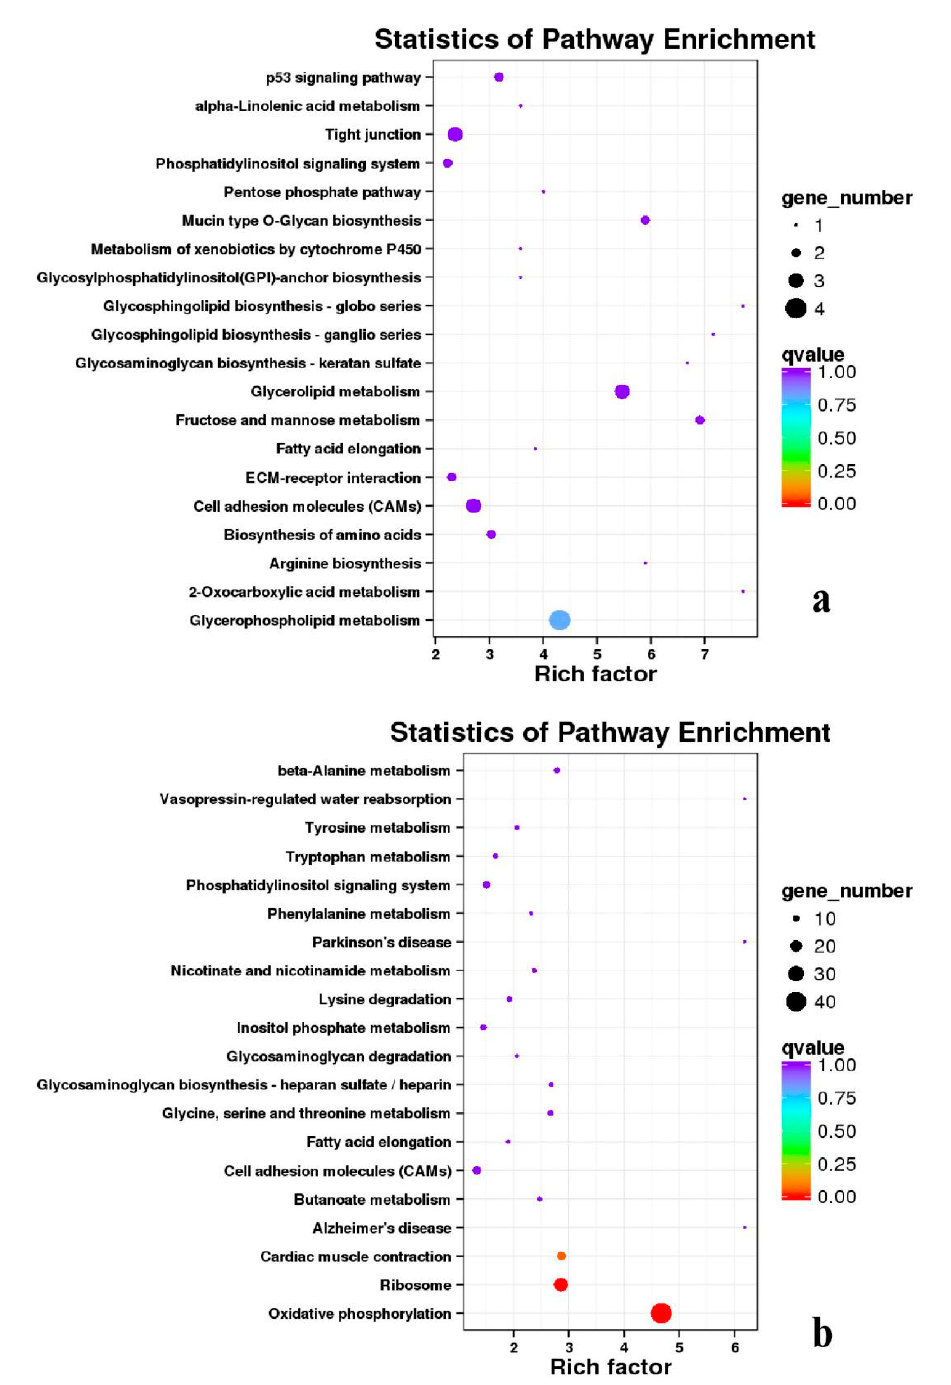
Figure 19. KEGG annotation of DEGs in the comparison of breast and leg muscle. ( a ) BE27B_vs_BE27L; ( b ) BE31B_vs_BE31L.